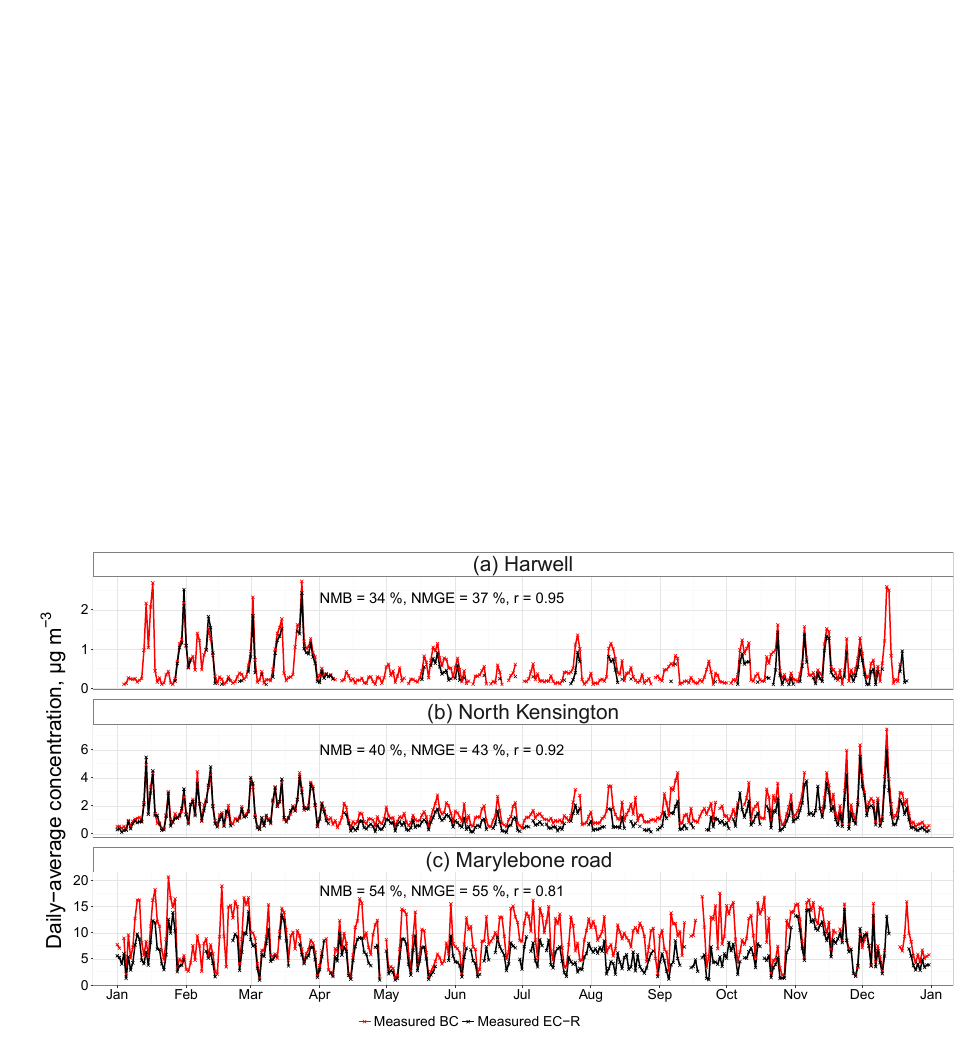
Figure A5. Time series of daily average measured EC-R and BC concentrations at the (a) Harwell, (b) North Kensington, and (c) Marylebone Road measurement sites, year